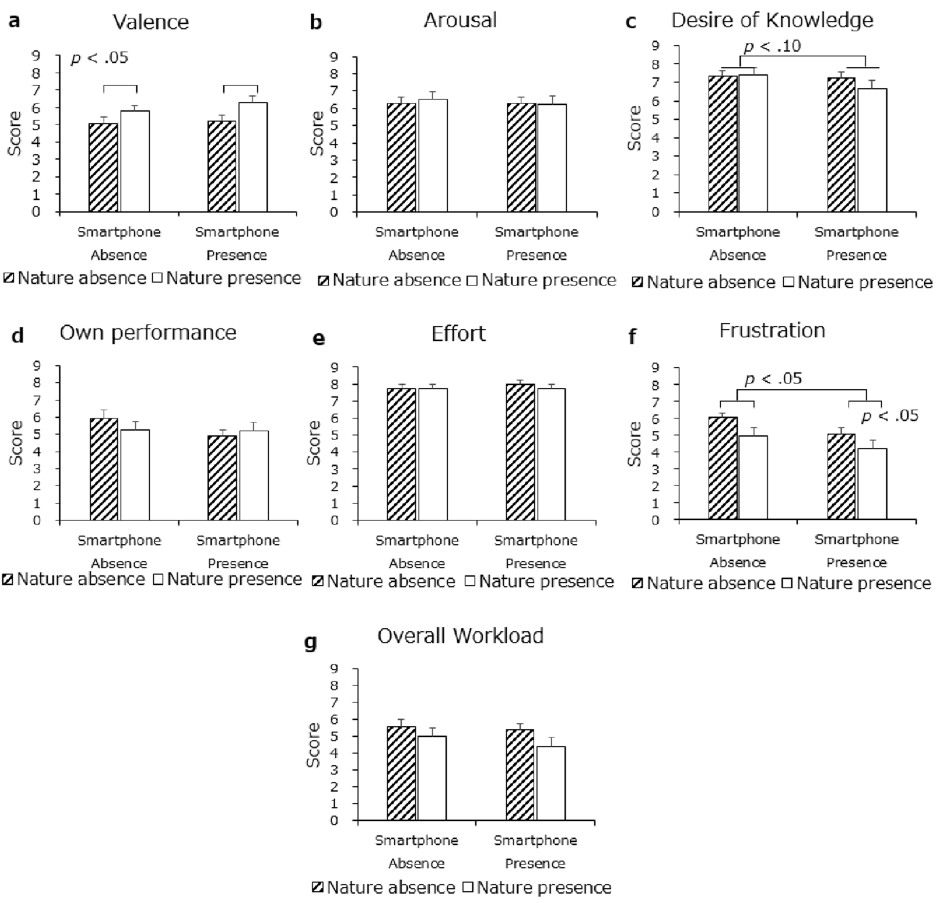
Figure 7. Mean subjective evaluations: ( a ) valence, ( b ) arousal, ( c ) desire of knowledge, ( d ) own performance, ( e ) effort, ( f ) frustration, and ( g ) overall workload. Error bars depict standard error